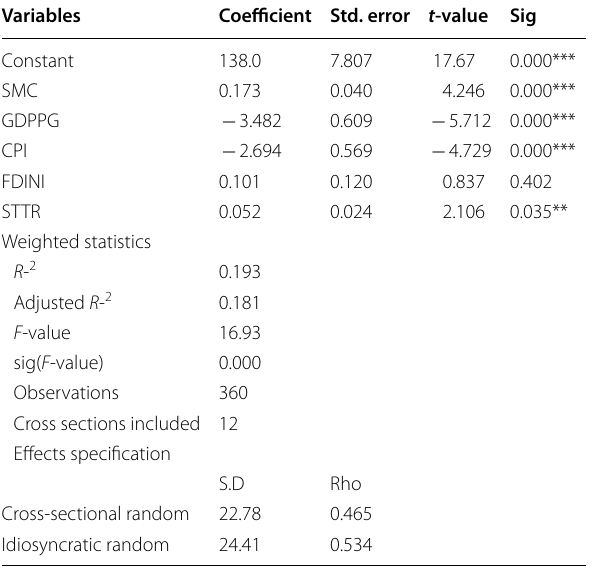
Table 6 Method: PANEL EGLS (cross-sectional random effects).